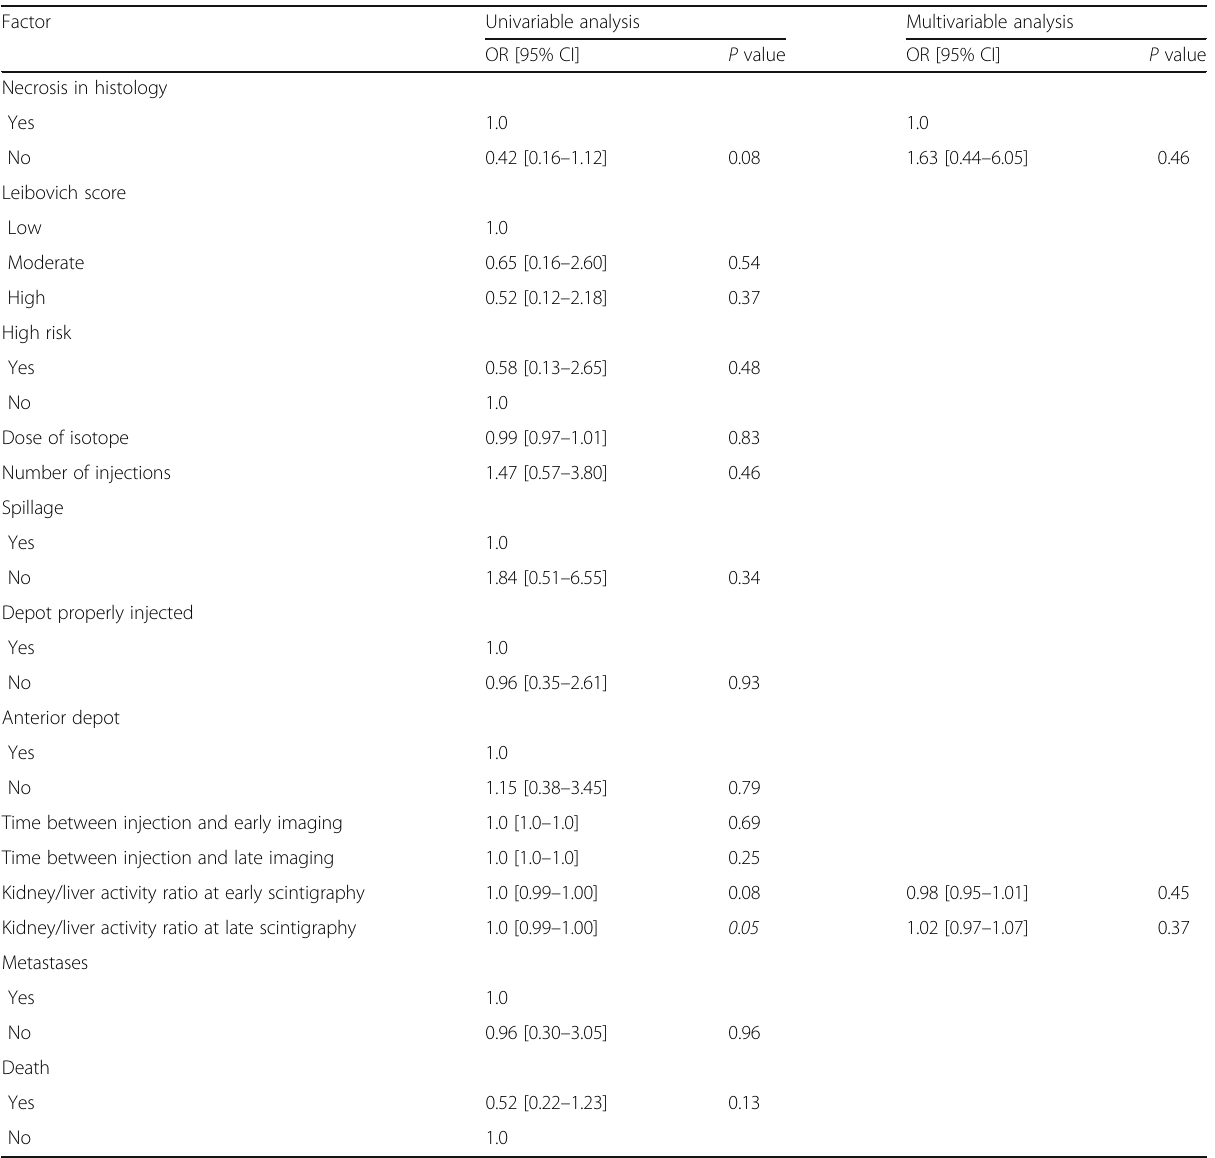
Table 1 Factors for visualization, univariable and multivariable analysis (Continued)